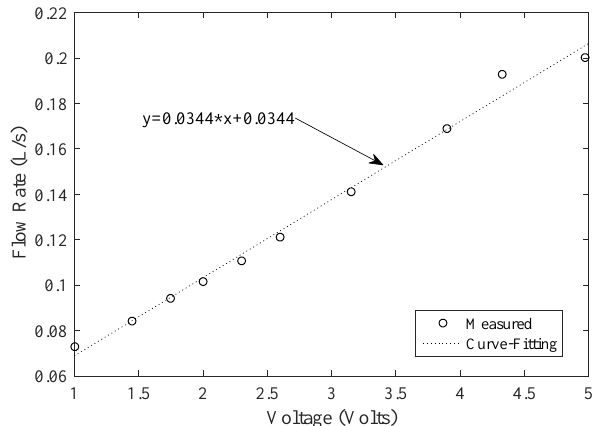
Figure 10. Voltage and flowrate relationships.